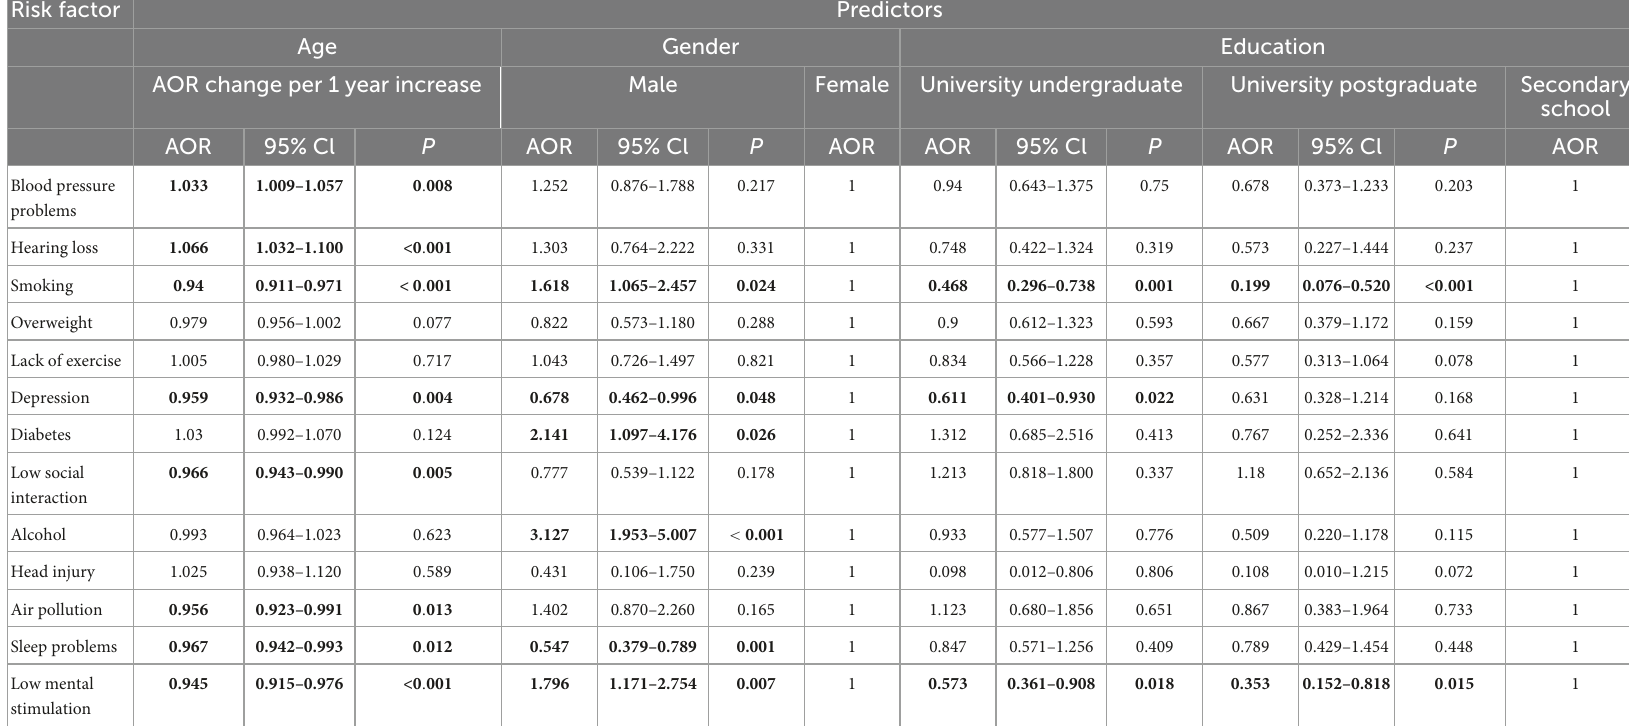
TABLE 3 Association between exposure to modifiable risk factors age, gender, and